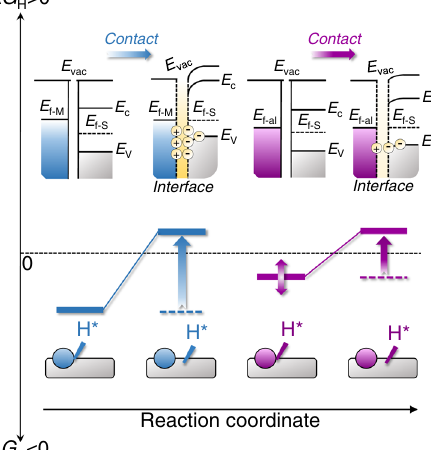
Fig. 1 Schematic illustrations of the interfacial electronic con fi gurations and hydrogen spillover phenomenon in HSBB catalysts. E vac = vacuum energy, E c = conduction band, E v = valence band, E f-M = Fermi level of metal, E f-al Fermi level of alloy, E f-S Fermi level of